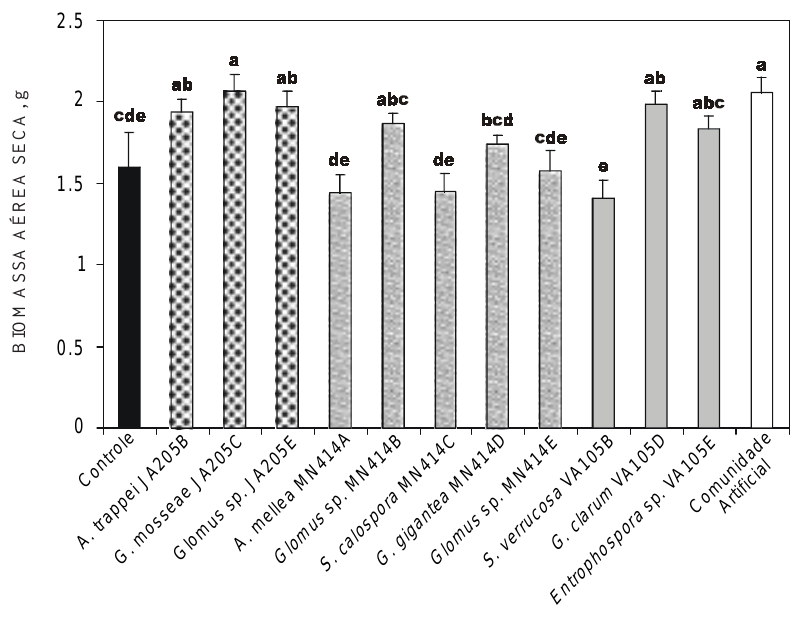
Figura 1. Biomassa aérea seca de plantas de soja inoculadas com isolados de FMAs originados de três comunidades distintas. Colunas representam a média de cinco repetições e barras representam o